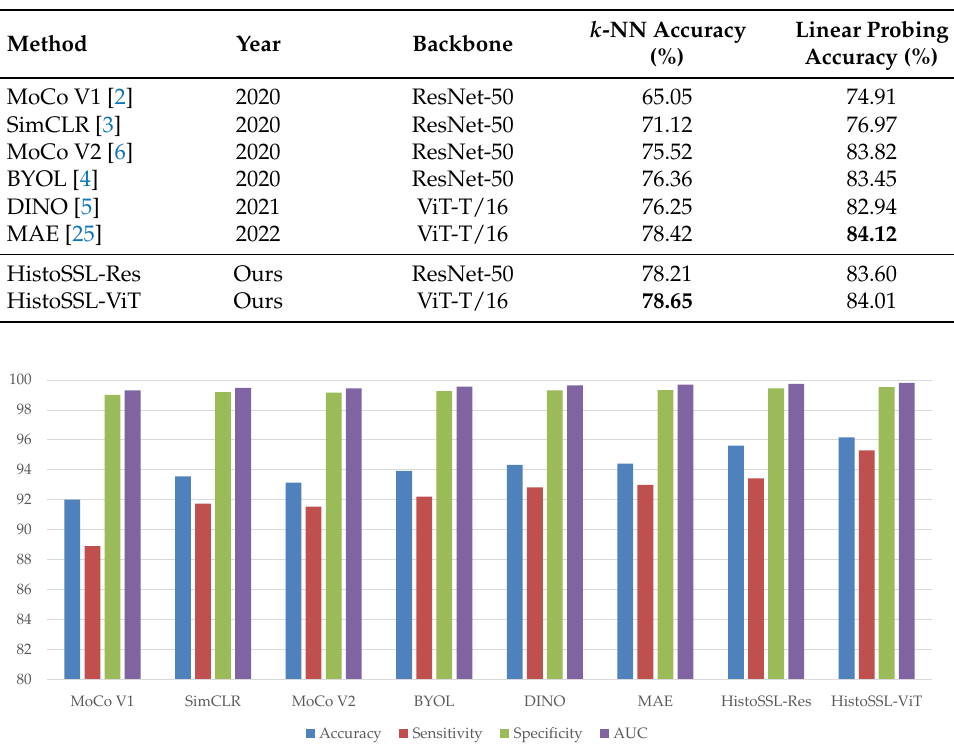
Figure 4. Sensitivity, specificity, and AUC results (%) on the NCTCRC